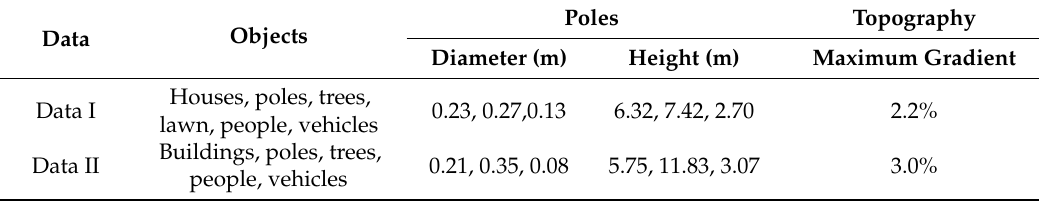
Table 7. The different characteristics between Data I and Data